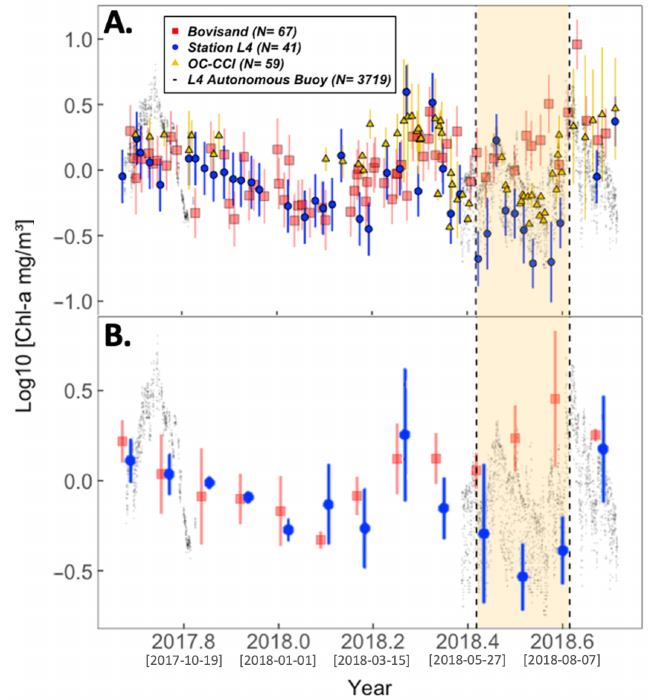
Figure 4. Seasonal cycles of chl- a captured at Bovisand and L4. ( A ) is the chl- a data for both Bovisand and L4 from various sources: Bovisand in-situ data are shown as red squares; L4 in-situ data are shown as blue circles (Station L4 CTD data) and black dots (L4 autonomous buoy). Auxiliary satellite OC- CCI chl- a data at L4 are shown as yellow triangles. ( B ) Monthly binned averages of Bovisand in-situ data and Station L4 in-situ data with L4 autonomous buoy data underlain to assist in visualising the seasonal cycle. In ( A ), the vertical bars for Bovisand and Station L4 data represent the measurement uncertainty (Section 2.2.4) and the standard deviations of the OC-CCI data. In ( B ), the vertical bars are the standard deviation of the monthly bins with the exception of the August bin at L4, which only consisted of one value and so represents the uncertainty of that measurement. The yellow shaded area represents the summer period June to August. All chl- a data are log 10 transformed. Square bracketed dates on the x-axis ticks represent